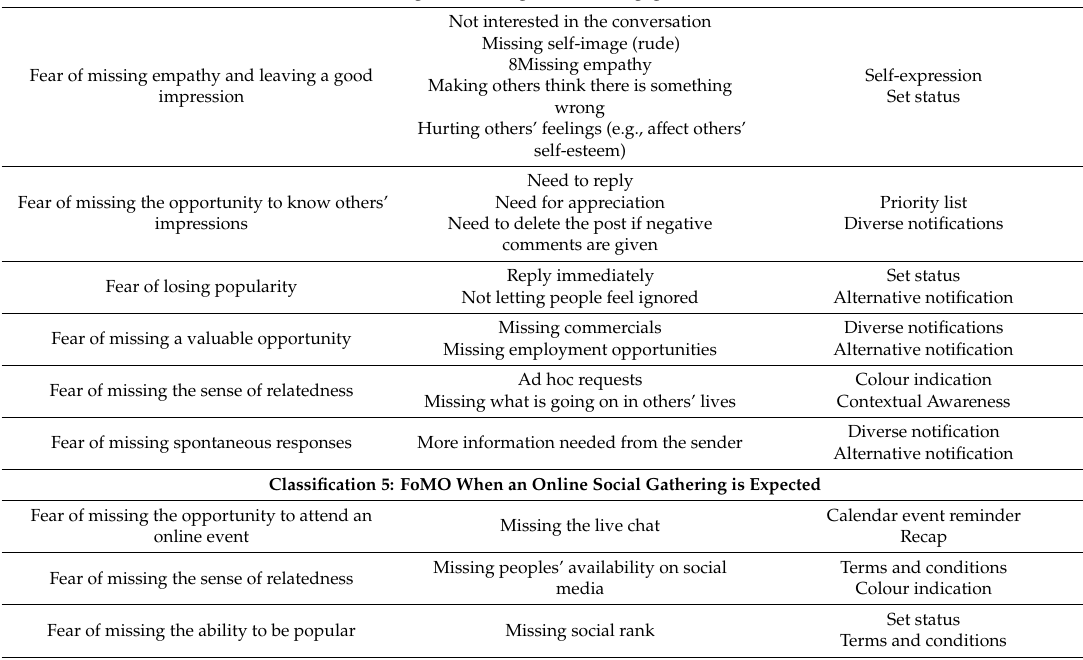
Classification 4: FoMO When Having to or Feeling a Need to Engage in Continuous Untimed Interactions